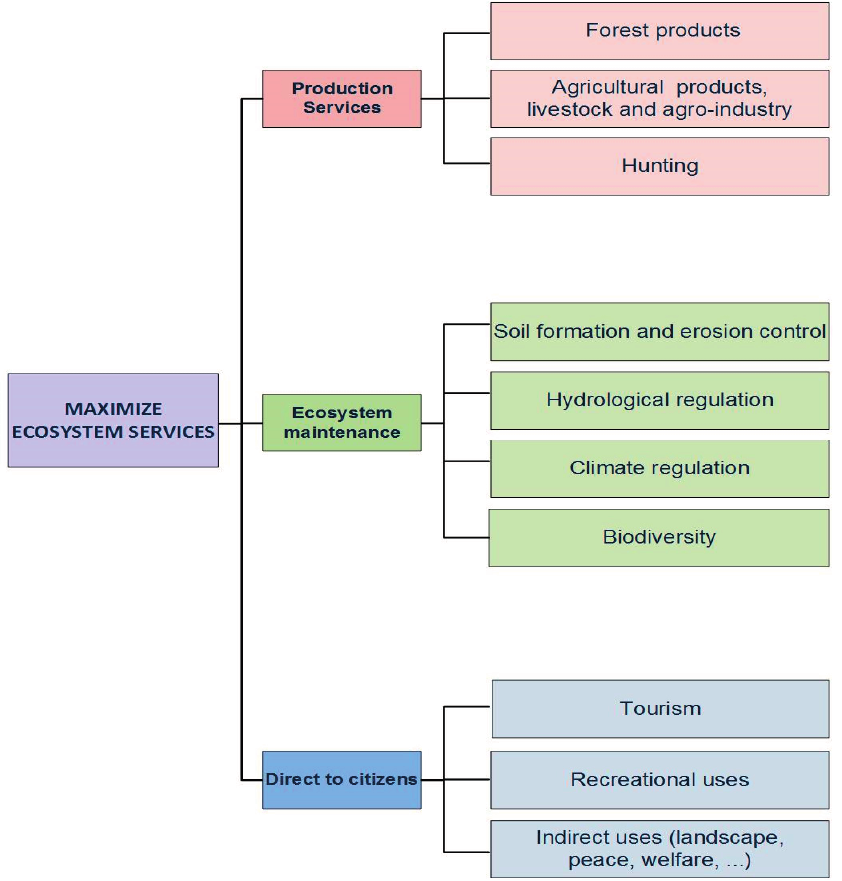
Figure 3. Ecosystem services hierarchy of Serra d’Espadà Natural